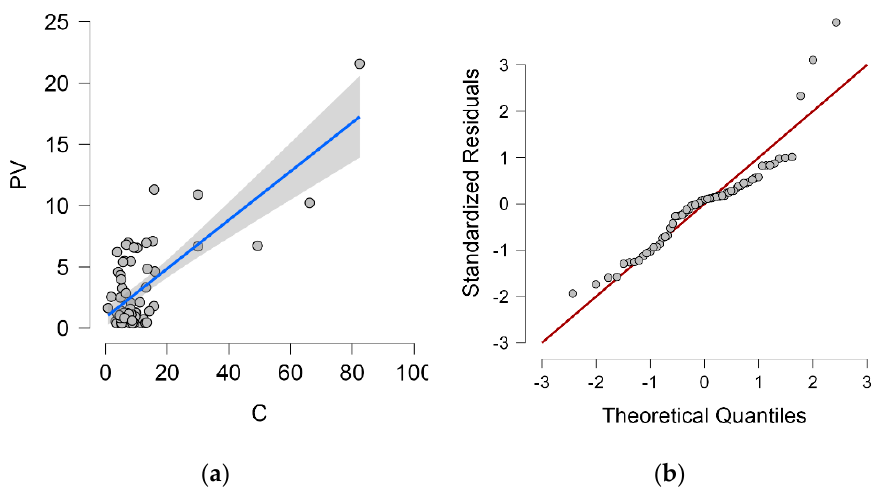
Figure 4. Vertical dry plate method and wet candle method. ( a ) Dependence of vertical dry plate method values and 95% confidence interval (grey area) on wet candle method values; ( b ) Q-Q plot.